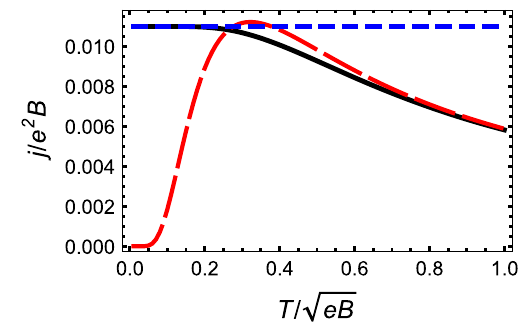
√ √ | eB | for | eB | η = 0 . 5